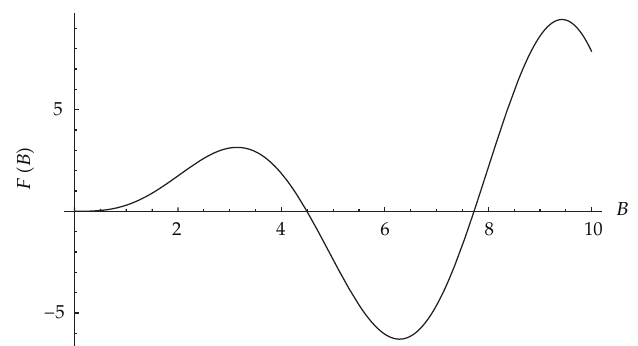
Figure 5: Graph of F (cid:3) B (cid:4) (cid:5) sin B − B cos B against B for B in the range (cid:6) 0,10 (cid:7) .